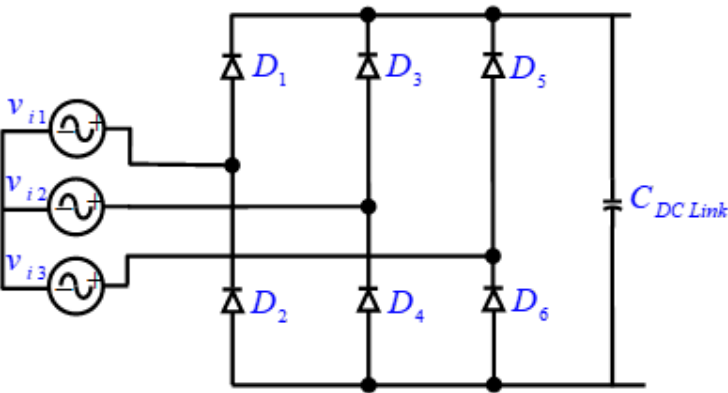
Figure 12. Grid side converter of the fast-charging station.